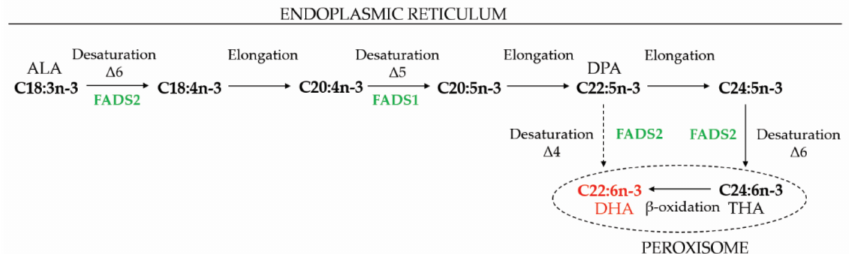
Figure 3. De novo biosynthesis of DHA. ALA is elongated and desaturated to THA in the ER and subsequently retroconverted to DHA via one cycle of peroxisomal β -oxidation (also known as the “Sprecher shunt”). However, whereas it was previously thought that DPA cannot be directly converted to DHA, FADS2 activity on DPA was recently shown [99], but the contribution to DHA synthesis in different cell types has not been resolved. ALA, α -linolenic acid; DHA, docosahexaenoic acid; DPA, docosapentaenoic acid; FADS, fatty acid desaturase; THA, tetrahexaenoic acid. To date, defects in seven proteins involved in the different steps of peroxisomal β - oxidation have been identified and include (i) the ABCD1 transporter, (ii) multifunctional protein 2 (MFP2), (iii) acyl-CoA oxidase 1 (ACOX1), (iv) α -methylacyl-CoA racemase (AMACR), (v) acyl-CoA oxidase 2 (ACOX2), (vi) the ABCD3 transporter and (vii) sterol